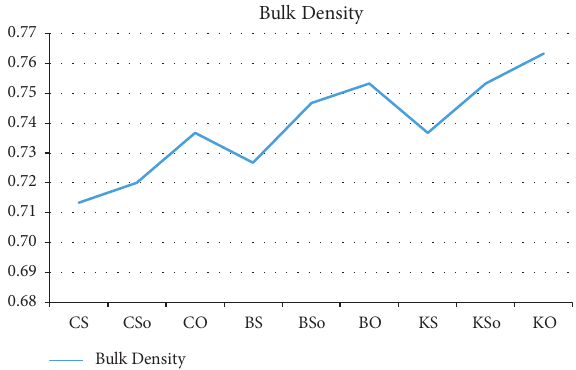
Figure 2: Bulk density of anchote flours. CS: control and sun-dried sample, CSo: control and solar-dried sample, CO: control and oven-dried sample, BS: blanching and sun-dried sample, BSo: blanching and solar-dried sample, BO: blanching-oven-dried sample, KS: potassium metabisulphite and sun-dried sample, KSo: potassium metabisulphite and solar-dried sample, and KO: po- tassium metabisulphite and oven-dried